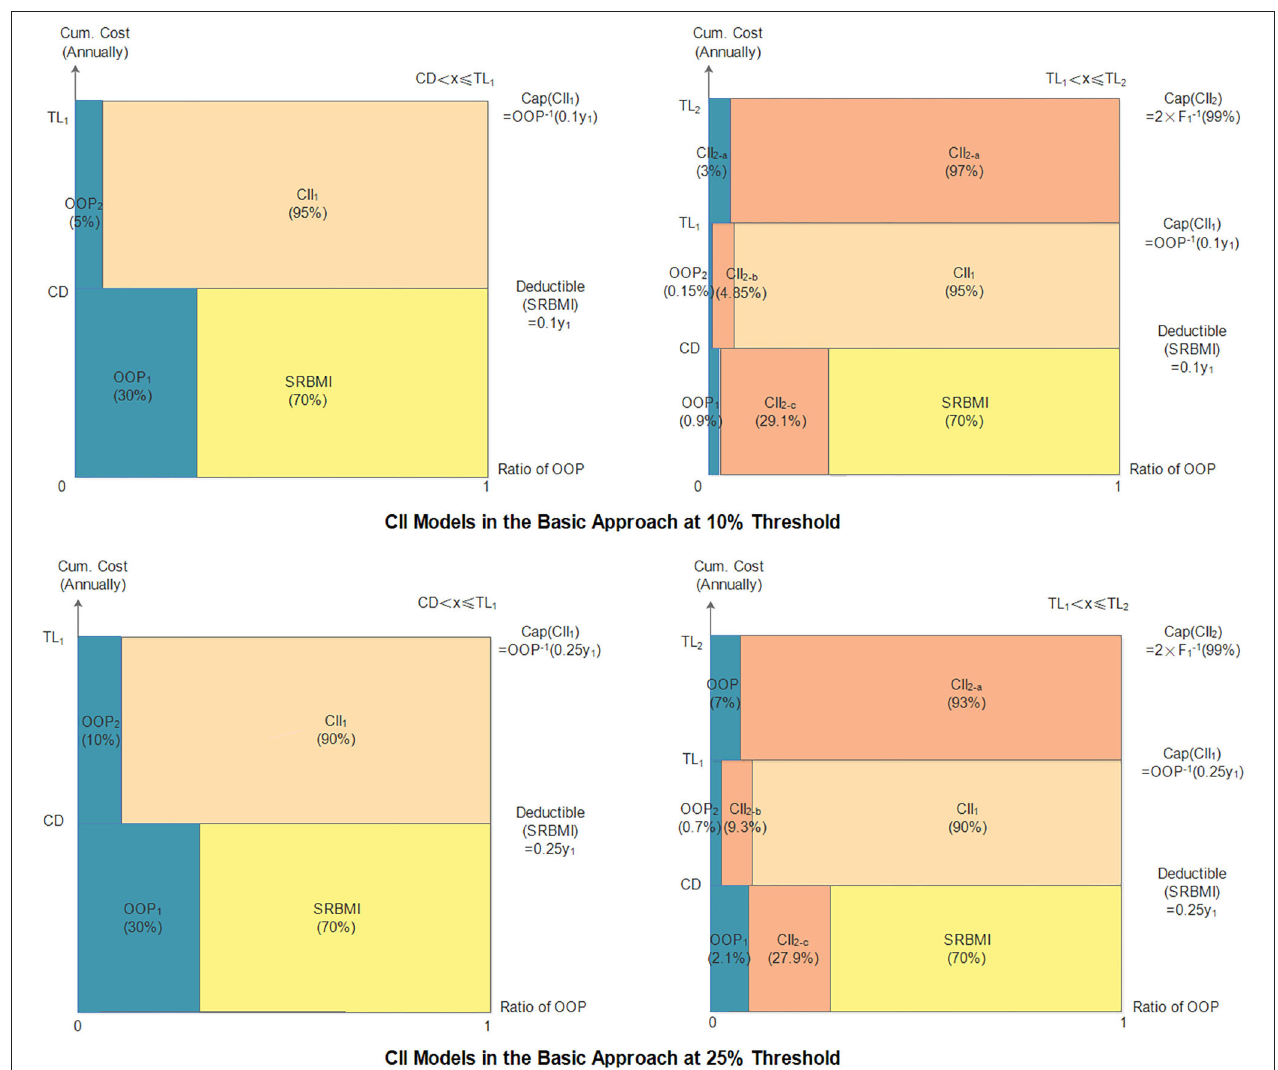
FIGURE 3 | CII models in the basic